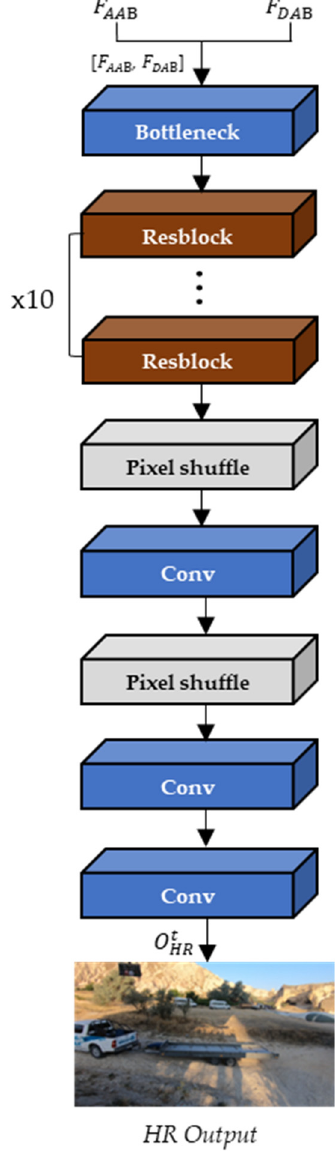
Figure 9. The architecture of the up-sampling block.